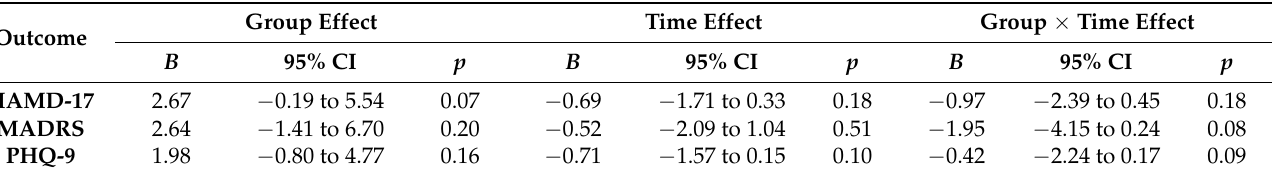
Table 4. Comparison of the effects in treating major depressive disorder for 4 weeks between bright light therapy and dim red-light groups, using hierarchical linear mixed-modeling a to show group and time effects and interaction of group and